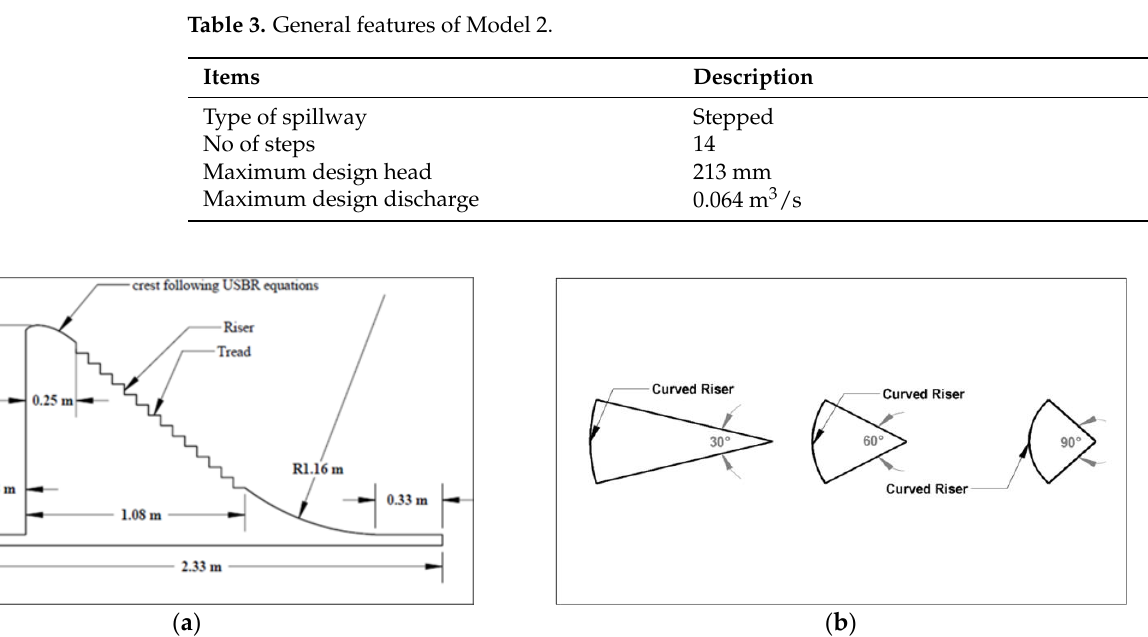
Figure 1. ( a ) Pictorial View of Model 2; ( b ) Magnitude of Curvature.